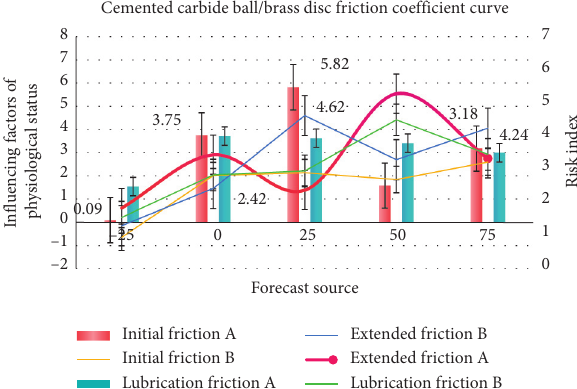
Figure 2: Cemented carbide ball/brass disc friction coefficient curve.